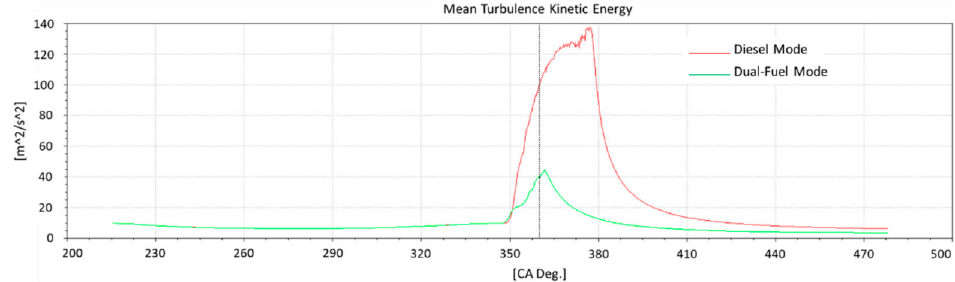
Figure 8. The mean TKE of the fluid flow in the engine cylinder in both operating modes.